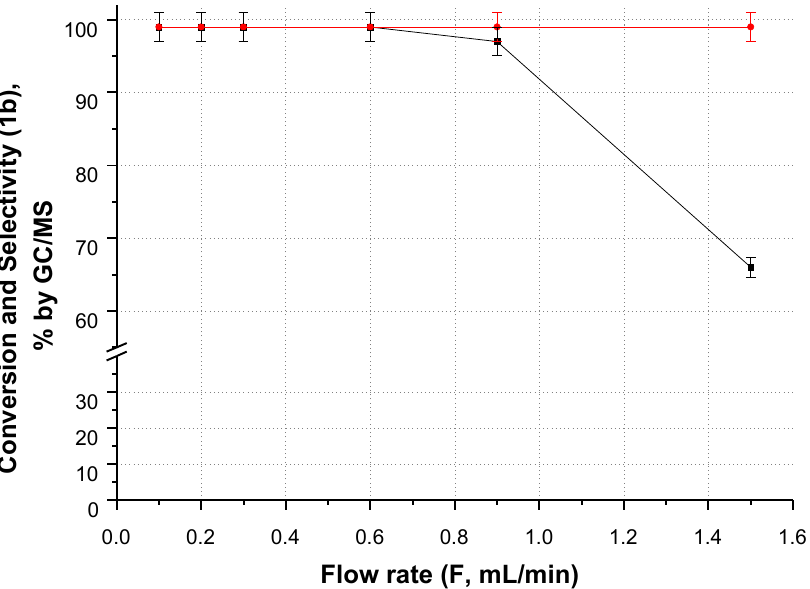
Figure 2. The effect of the flow rate (F) on CF-acetalization of amide 1a . Other conditions were those of entries 1-2 in Table 1: 30 °C, 1 atm, A15 catalyst (0.8 g), 0.1 M solution of 1a in acetone. ( - ■ - ) 1a conversion; ( - ● - ) 1b selectivity.